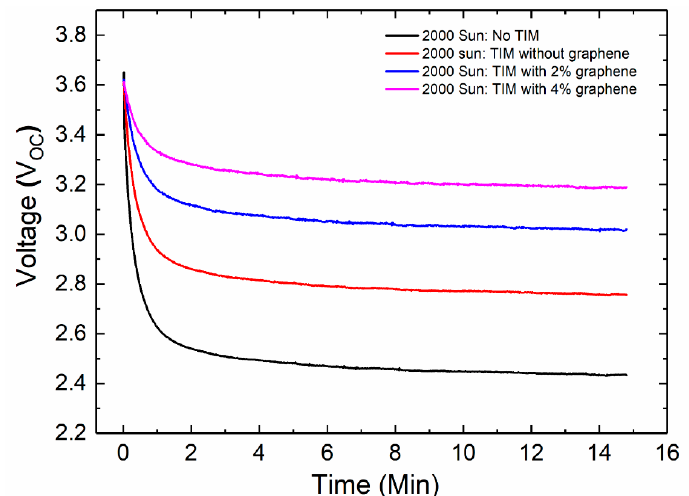
Figure 9. Open-circuit voltage of the solar cell under concentrated illumination corresponding to 2000 suns. The results are shown for the cell without thermal interface material, for the same cell with commercial thermal interface materials, and for the same cell with graphene-enhanced thermal interface materials. Note that the use of 4% graphene fillers added to commercial thermal paste allows for substantial increase in the open-circuit voltage.